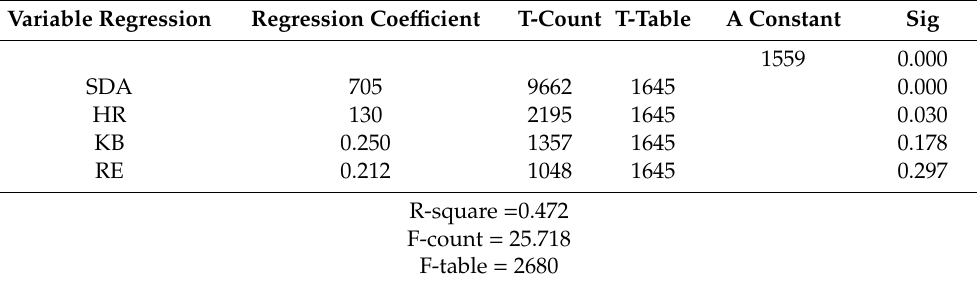
Table 5. Summary of Statistical Results of Multiple Regression